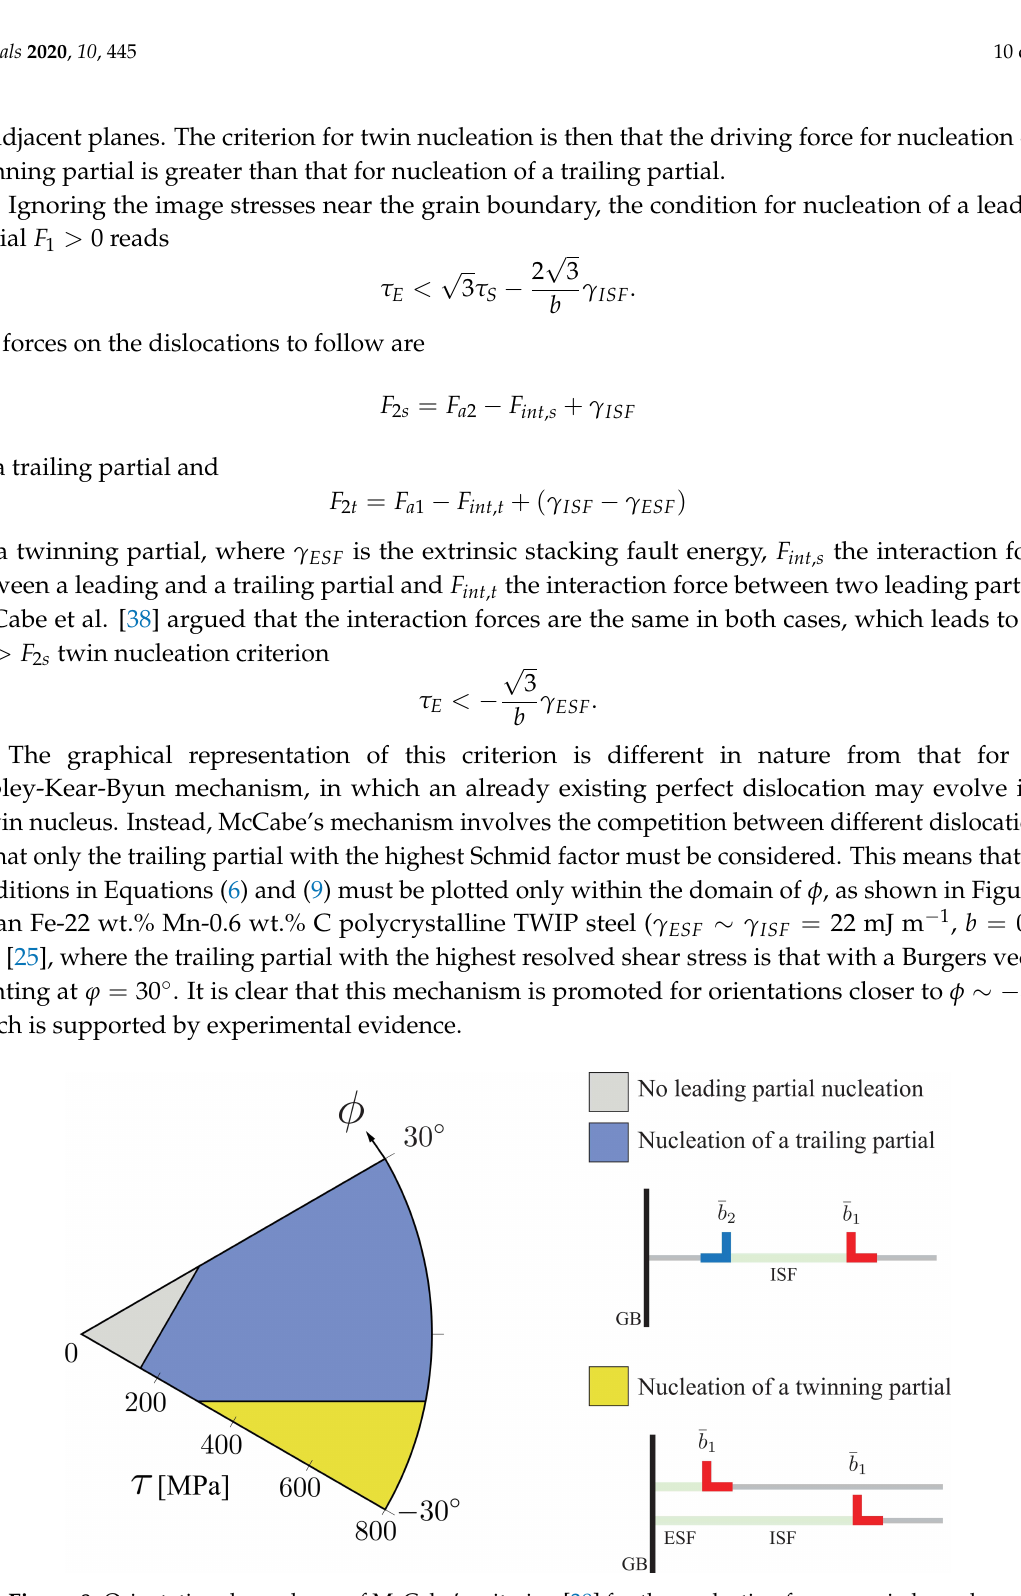
Figure 8. Orientation dependence of McCabe’s criterion [38] for the nucleation from a grain boundary of a trailing partial bounding an intrinsic stacking fault or a twinning partial on an adjacent plane giving rise to an extrinsic stacking fault. Calculated for an Fe-22 wt.% Mn-0.6 wt.% C TWIP steel ( γ ESF ∼ γ ISF = 22 mJ m − 1 , b = 0.25 nm) [25]. As this model is based on the competition